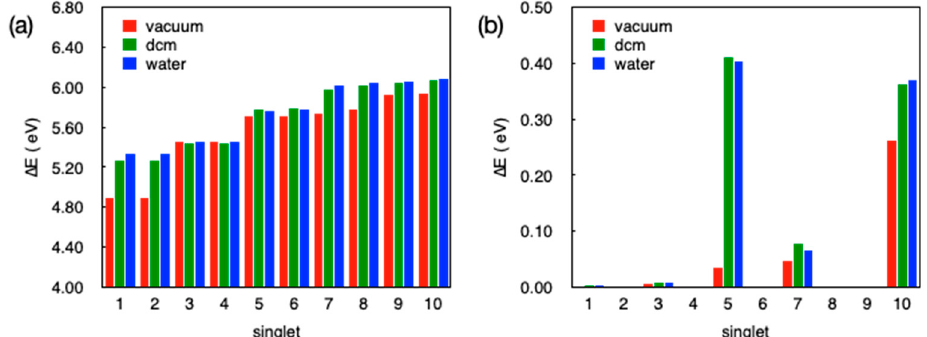
Figure 9. Transition energies ( a ) and oscillator strengths ( b ) for the ten lowest excited singlet states S 1 –S 10 of the isolated ZnL 2 (H 2 O) 2 complex in vacuum and in different solvents. The geometry of the complex considered in these calculations corresponds to the structural X-ray data obtained for 1 .